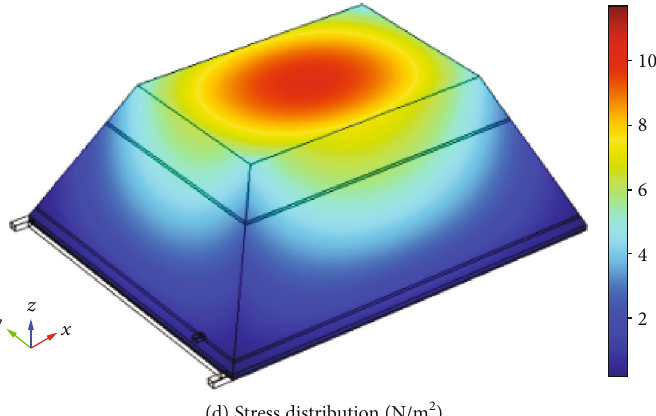
Figure 5: Distribution of seepage parameters in